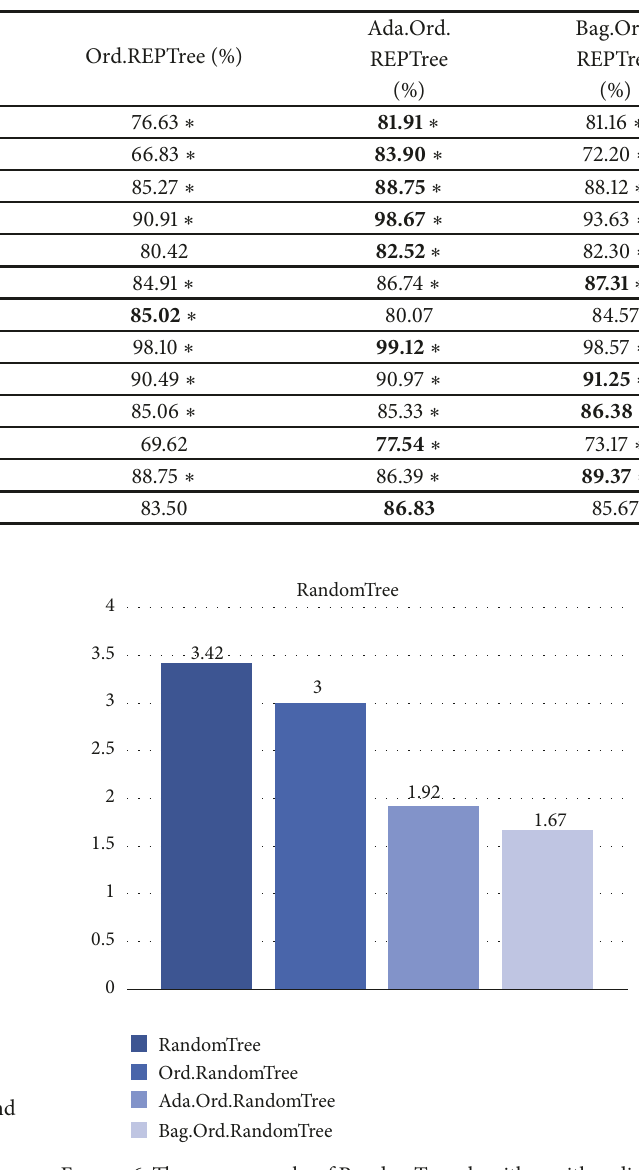
Figure 6: The average ranks of RandomTree algorithm with ordinal and ensemble-learning